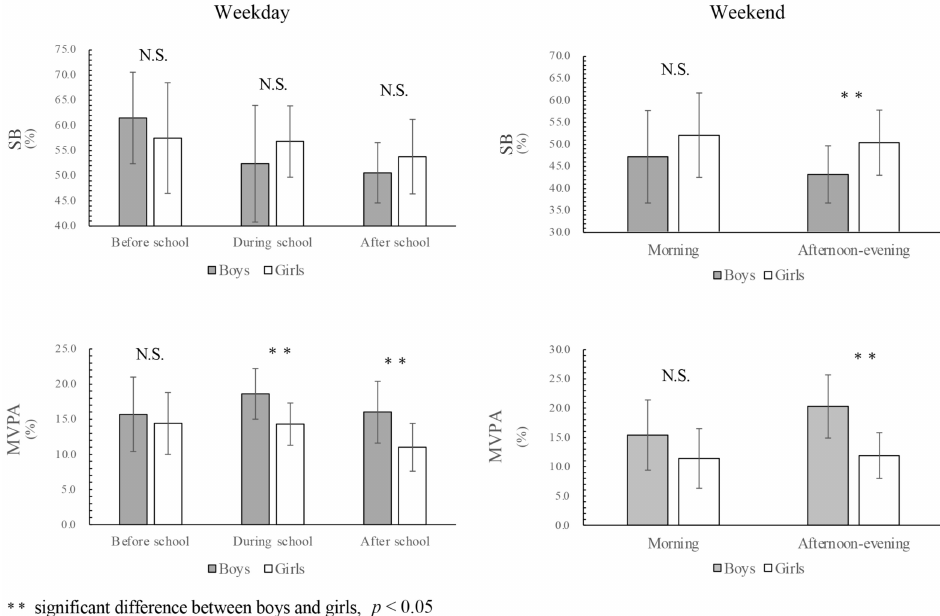
Figure 1. SB and MVPA with gender differences on weekdays and weekends.